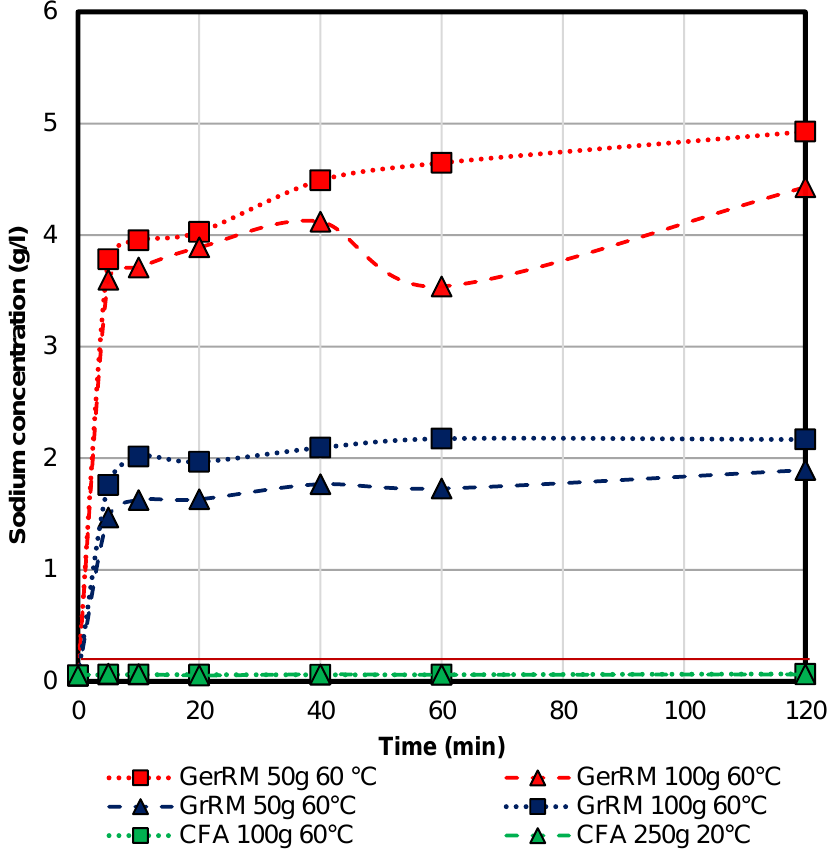
Figure A2. The concentration of sodium in treated acid mine drainage regarding the guidelines [18].